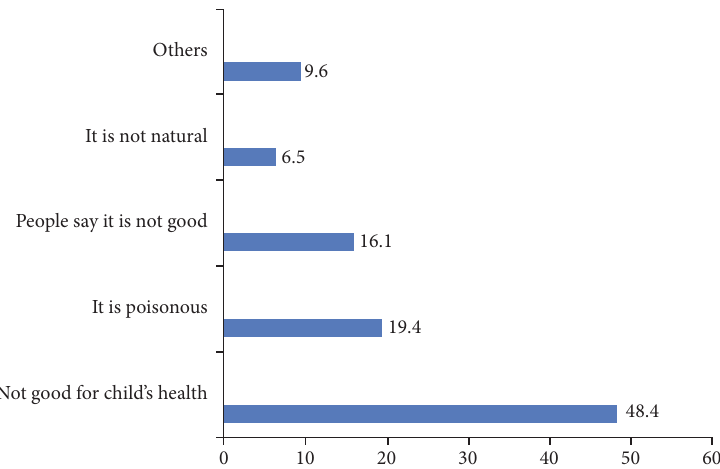
Figure 1: False beliefs about colostrum by respondents.